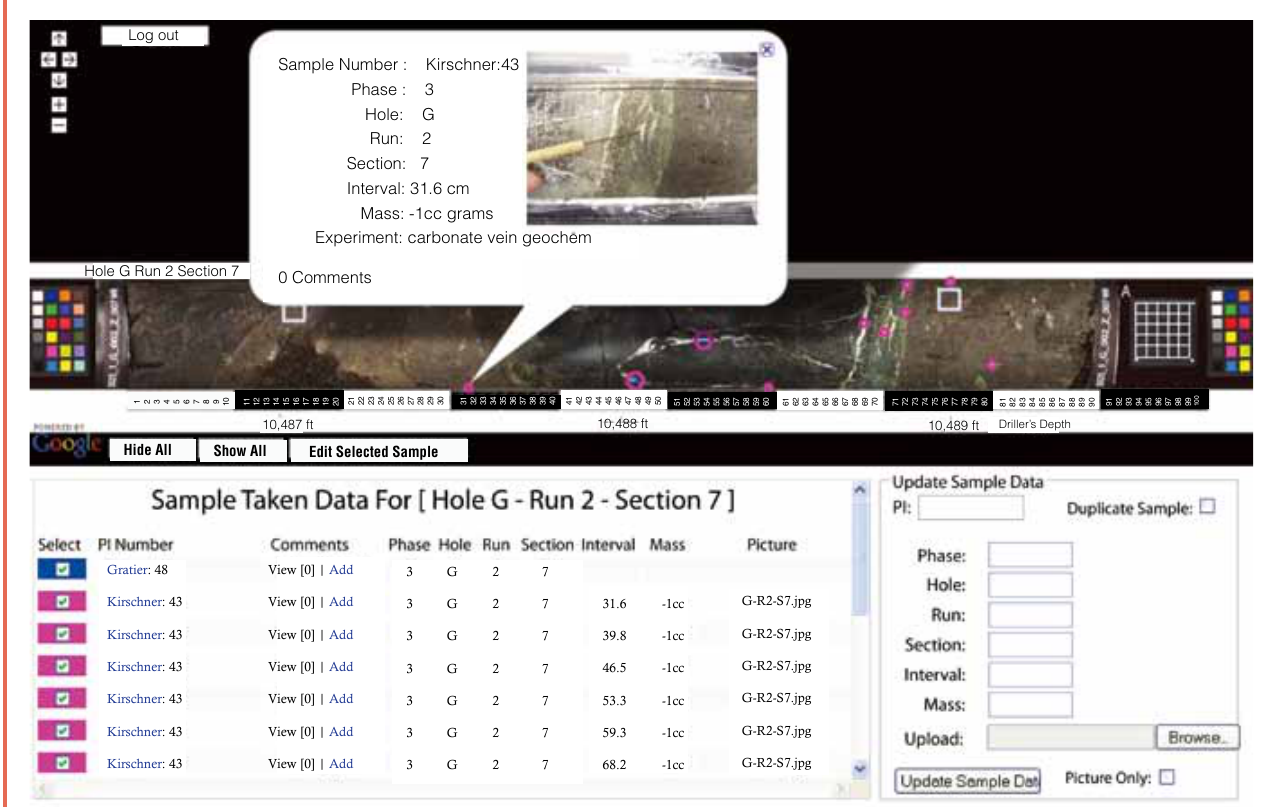
Figure 2. Example of SAFOD Core Viewer sample information taken from Round